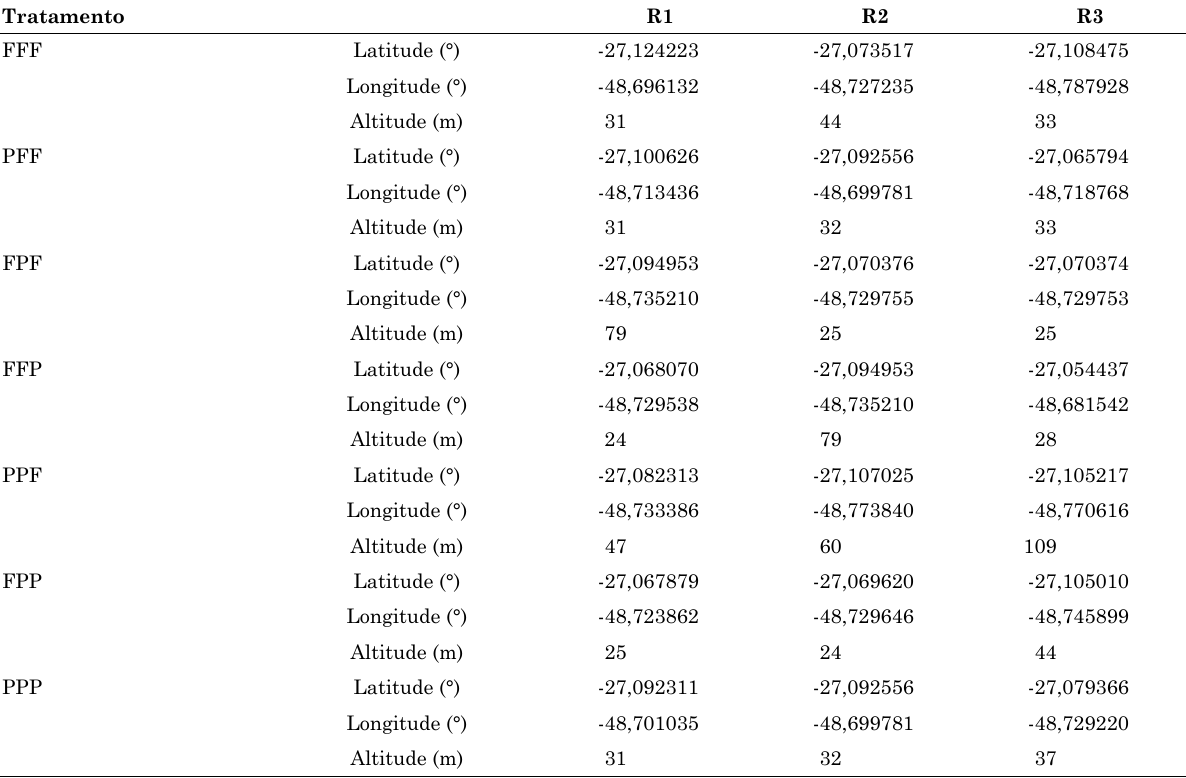
FFF: uso com floresta a mais de 70 anos; FPF: área ocupada nos últimos 25 anos por floresta, antecedida por um período de 25 anos por pastagem e anteriormente por floresta; PFF: uso com florestas nos últimos 50 anos e pastagem no período anterior a 1957; PPF: área ocupada nos últimos 25 anos com floresta, antecedida por pastagem; PPP: uso com pastagem a mais de 70 anos; FFP: uso com pastagem nos últimos 25 anos; e FPP: uso com pastagem nos últimos 25